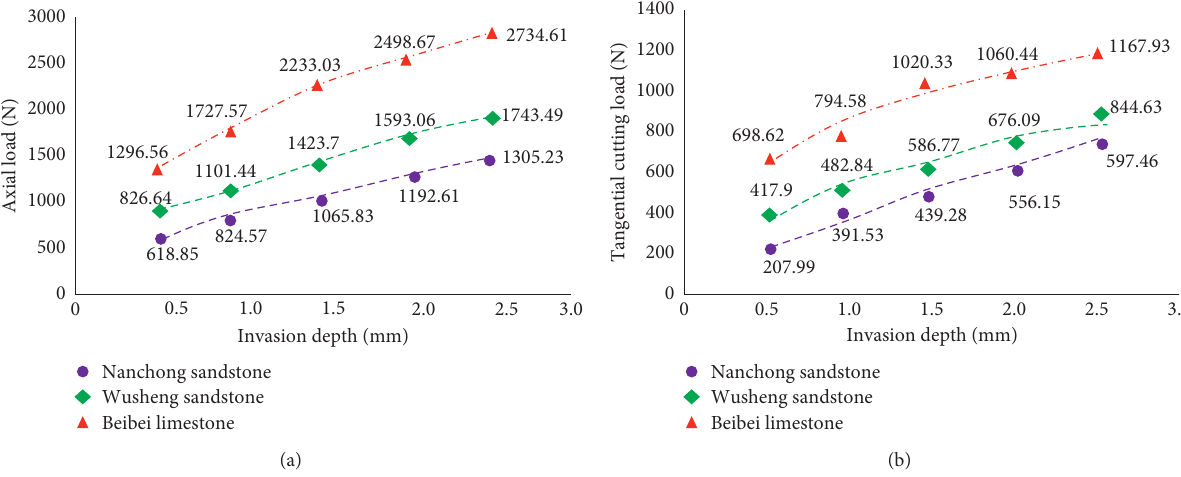
Figure 3: Raw data of the tooth cutting load measurement. (a) Trend of axial load change. (b) Trend of tangential load